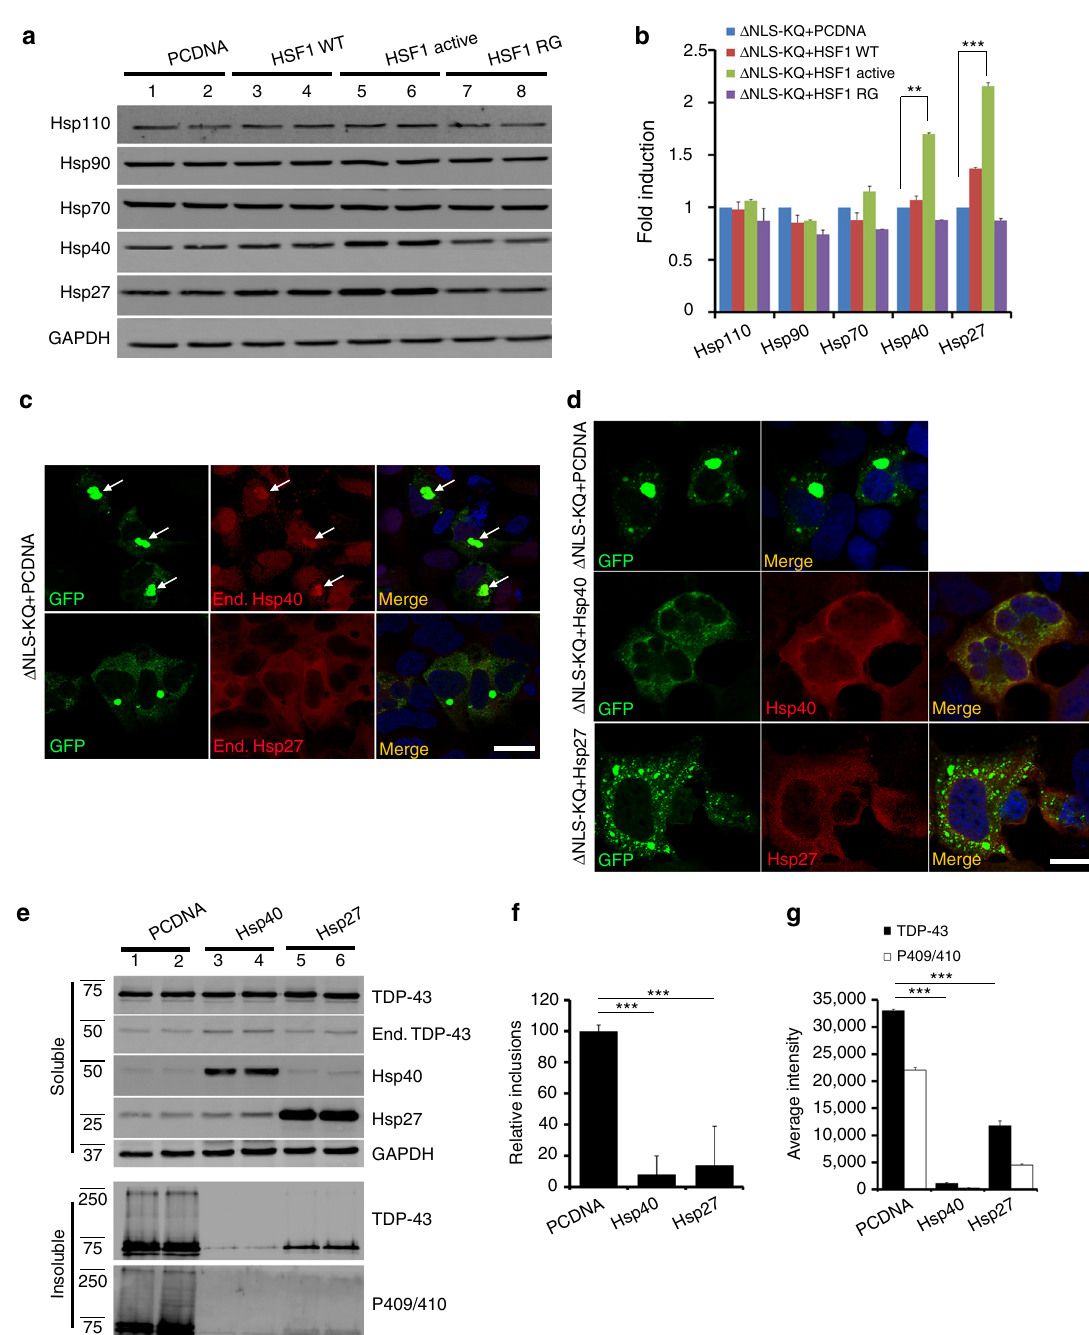
Fig. 8 HSF1-regulated heat shock protein (HSP) expression suppresses TDP-43 acetylation-mimic-induced aggregation. a Cells transfected with TDP-43- Δ NLS-K145Q in combination with control vector (pCDNA), wild-type HSF1, active HSF1, or inactive HSF1 (R71G) were analyzed by immunoblotting using Hsp110, Hsp90, Hsp70, Hsp40, Hsp27, or GAPDH antibodies. b Fold induction of heat shock proteins from a above was quanti fi ed and